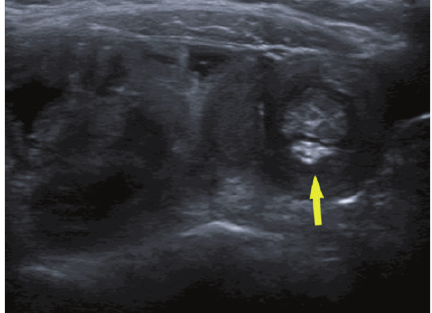
Figure 1: Axial lung window CT image shows a large thin walled cyst (asterisk) with a single septation (arrow) in the left lower lobe that is proved to be a type I PPB.